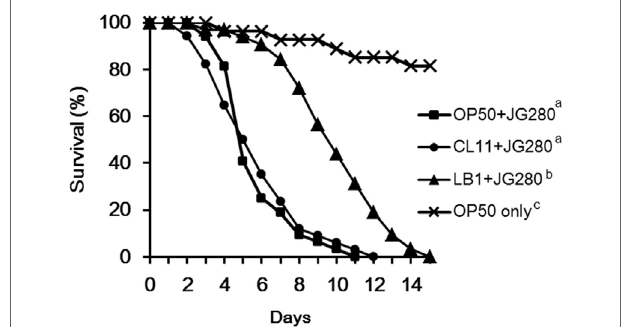
FigUre 1 | Effects of feeding isolates LB1 ( Lactobacillus zeae ) and CL11 ( Lactobacillus casei ) on the survival of the wild-type Caenorhabditis elegans (N2) after infection with Enterotoxigenic Escherichia coli (ETEC) JG280. The worms were first fed either with E. coli OP50 or Lactobacillus (isolate LB1, CL11) at 10 8 CFU/ml for 18 h and then ETEC JG280 for the remaining days. Treatments: ■ , E. coli OP50 and then ETEC JG280; ● , isolate CL11 and then ETEC JG280; ▲ , isolate LB1 and then ETEC JG280; and × , treated with E. coli OP50 only. All the groups showing different letters were significantly different ( P ≤ 0.01) in their survival